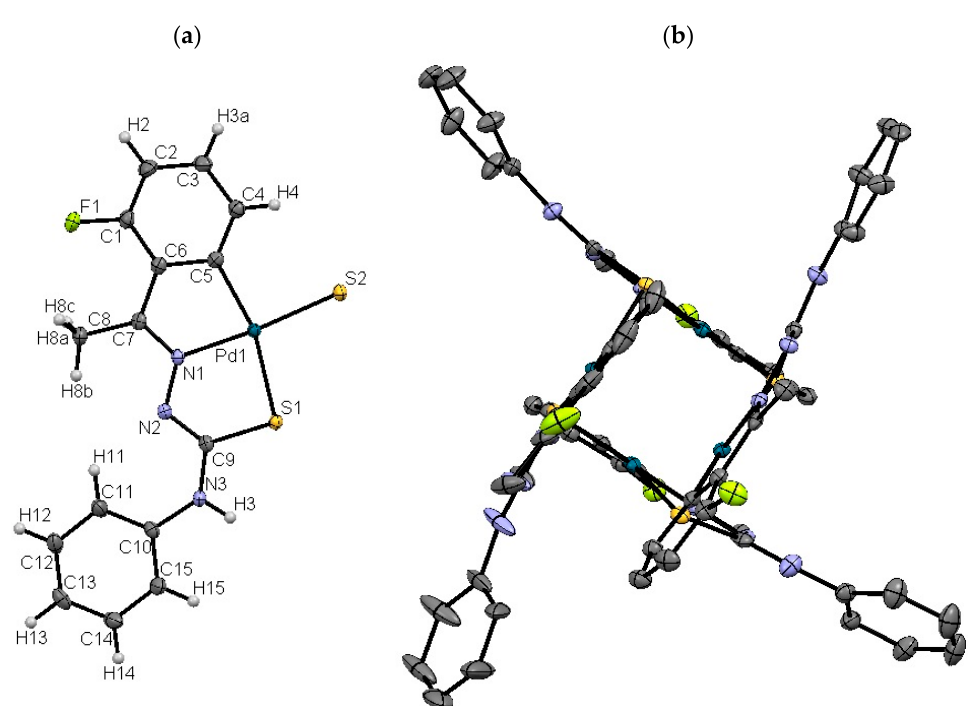
Figure 3. ( a ) Molecular structure of a monomer of 4b . Thermal ellipsoids are shown at 50% probability level. ( b ) Molecular structure of 4b , with antiparallel and perpendicular arrangement of each thiosemicarbazone.